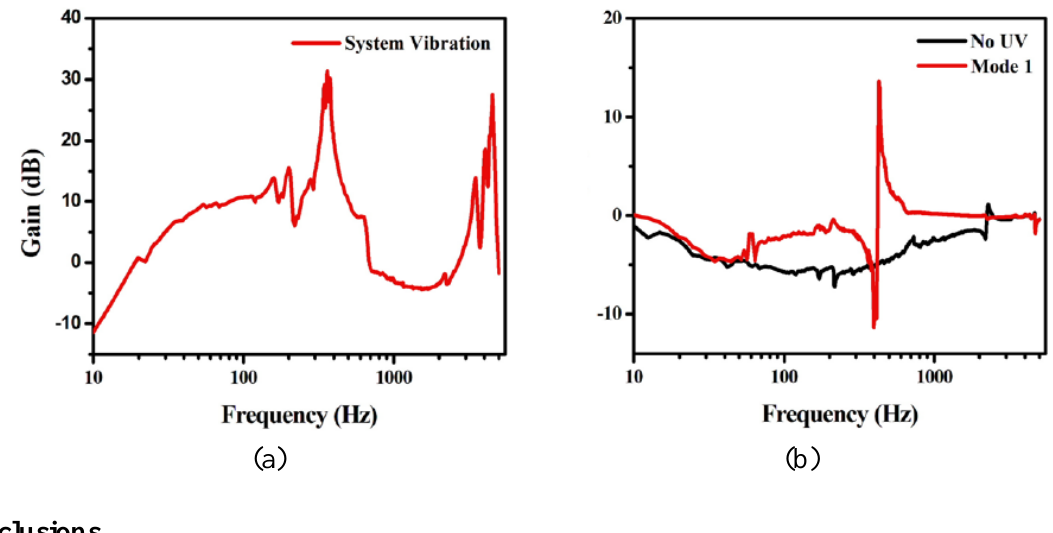
Figure 6. (a) The eigen-frequency of the vibration of optical modal sensor system measured from the top optical modal sensor by using a dynamic signal analyzer (SR780). (b) Transfer function of the optically defined modal sensor system treated without and with specific patterns as measured by the